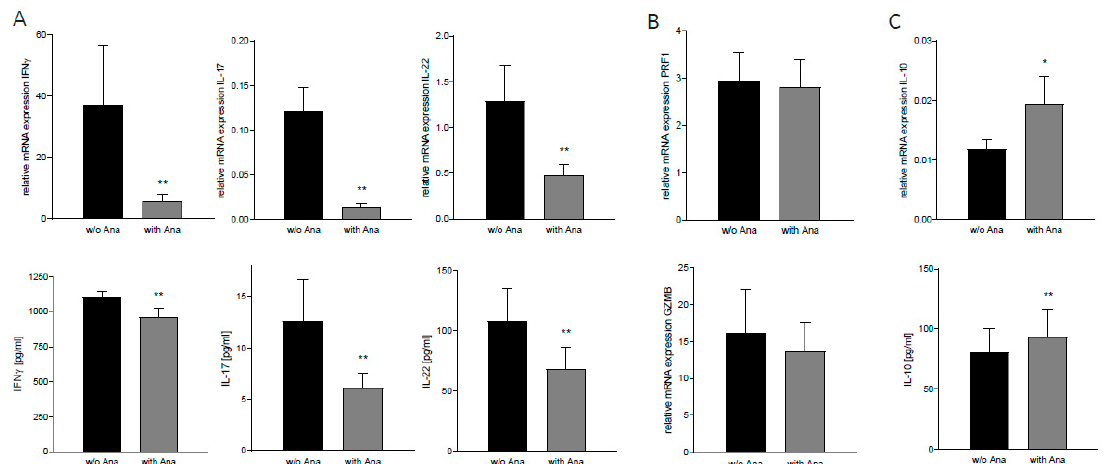
Figure 5. Anakinra reduced inflammatory signaling in lymphocytes co-cultured with T98G cells. T cells were isolated from PBMC after indirect co-culture with or without (w/o) anakinra (Ana). Protein levels in conditioned media from indirect co-cultures were assessed by enzyme-linked immunosorbent assay (ELISA). ( A ) mRNA and protein levels of proinflammatory cytokines IFN γ , IL-17, and IL-22 (mRNA: n = 13; protein: n = 10, p < 0.004). ( B ) mRNA expression of cytotoxic T-cell effector molecules PRF1 and GZMB (n = 9). ( C ) mRNA and protein level of anti-inflammatory cytokine IL-10 (mRNA: n = 13, p = 0.038; protein: n = 10, p = 0.002). * p < 0.05, ** p < 0.01.